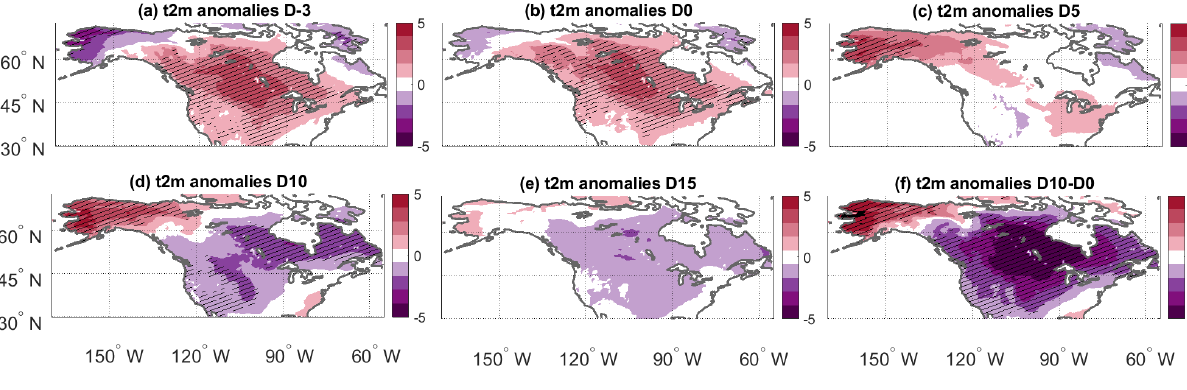
Figure 6. Composite-mean 2m temperature (t2m) anomalies at various lags relative to the reflection event onset. (f) Average difference between the t2m anomalies on day 10 and day 0 (i.e. d – b ). Hatching denotes statistically significant anomalies, assessed as described in Sect.